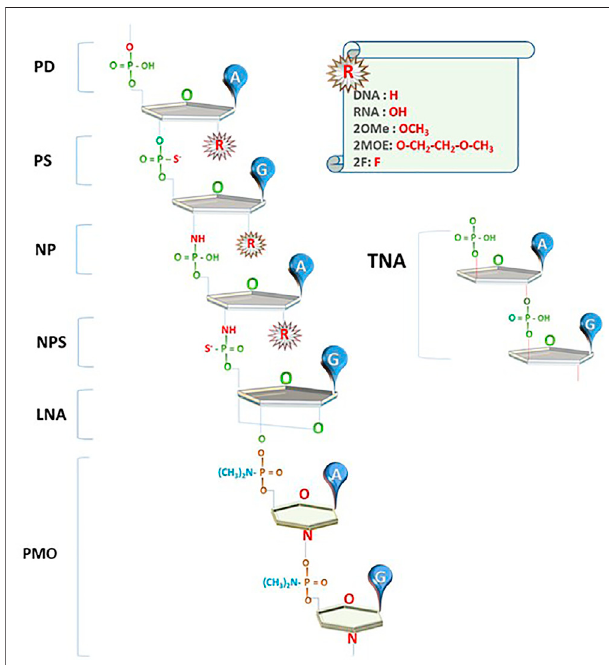
FIGURE 1 | Innovations in NBT chemistry. PD: oligonucleotides with phosphodiester bond (natural DNA/RNA); PS: phosphorothioate bond; NP: N3 ’ -- > P5 ’ phosphoramidate bond; NPS: N3 ’ -- > P5 ′ thio-phosphoramidate bond; LNA: locked nucleic acid unit; PMO: phosphorodiamidate Morpholino oligomer; TNA: α -l-threose-based; A, G: nucleotide bases; R: currently used 2 ′ O modi fi cations of the sugar